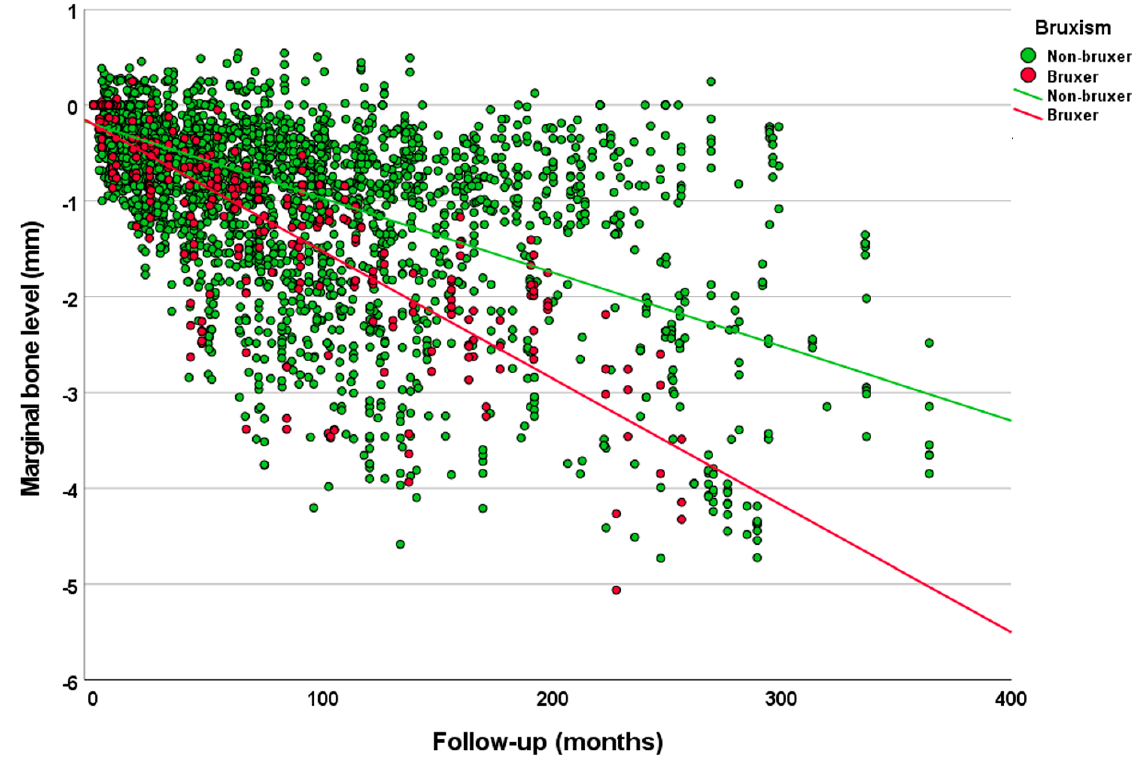
Figure 2. Scatter plot comparing the marginal bone level over time between implants placed in bruxers and non-bruxer patients (linear regression). The results of the linear mixed-effects model (Table 4) suggested that smoking degree (greater MBL for higher degrees of smoking), bruxism (greater MBL for bruxers), jaw (greater MBL in maxilla), implant diameter (greater MBL for regular diameter implants), and prosthesis fixation (greater MBL for screw-retained prosthesis) had a statistically sig- nificant influence on MBL over time. Table 4. Linear mixed-effects model for MBL. Predictor Variables